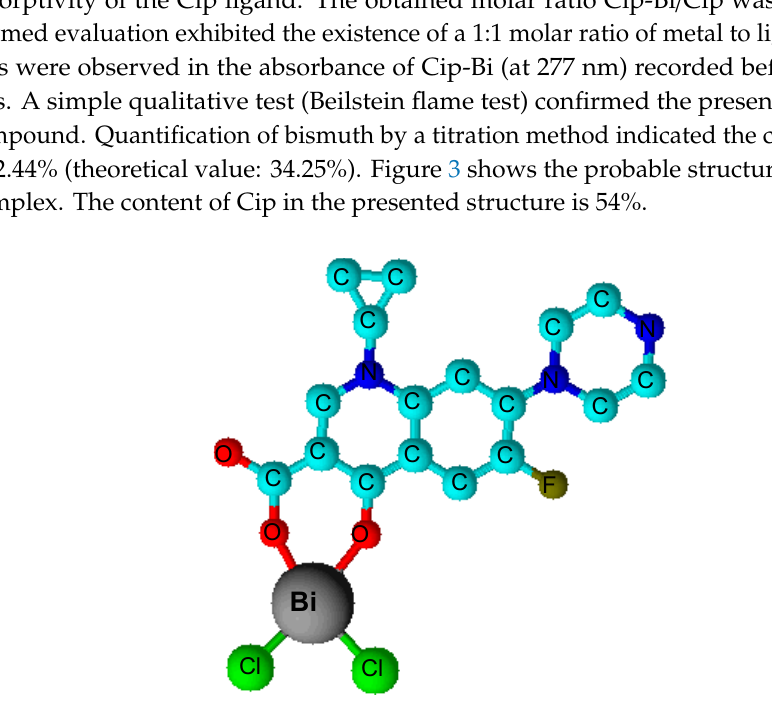
Figure 2. UV absorption spectra of ciprofloxacin ( A ) and ciprofloxacin-Bi complex ( B ) as a function of